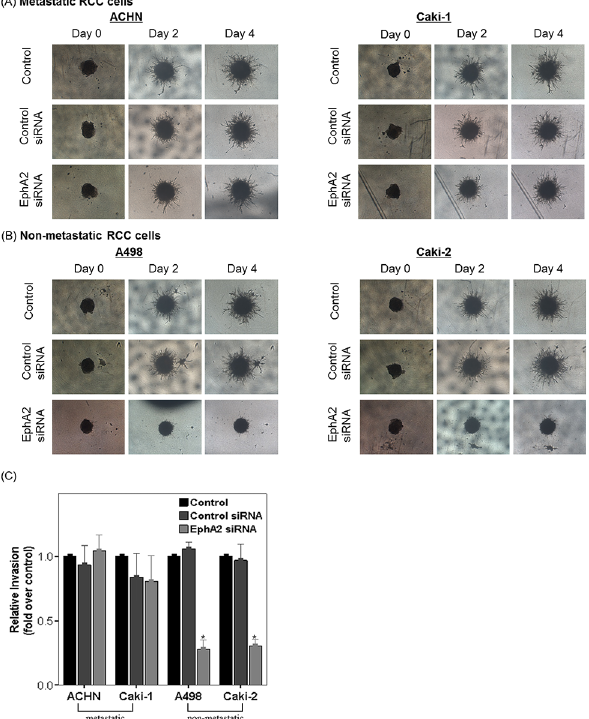
Fig 6. Effect of EphA2 siRNA on cellular invasiveness in 3-dimensional (3-D) cell culture models of human RCC cell lines. 3-D cell invasion was compared among untreated cells (control), control siRNA treated cells and EphA2 siRNA treated cells in each cell line. Representative images taken over a four-day period (A) metastatic RCC cell lines (ACHN and Caki-1) and (B) non-metastatic RCC cell lines (A498 and Caki-2). (C) Bar graph showing relative invasion in each cell line. Relative invasion was defined as a ratio: (the area obtained on day 4)/ (the area obtained on day 0). The results were presented as fold changes over controls. * p < 0.05 vs. control and control siRNA treated groups. siRNA = small interfering RNA, RCC = renal cell